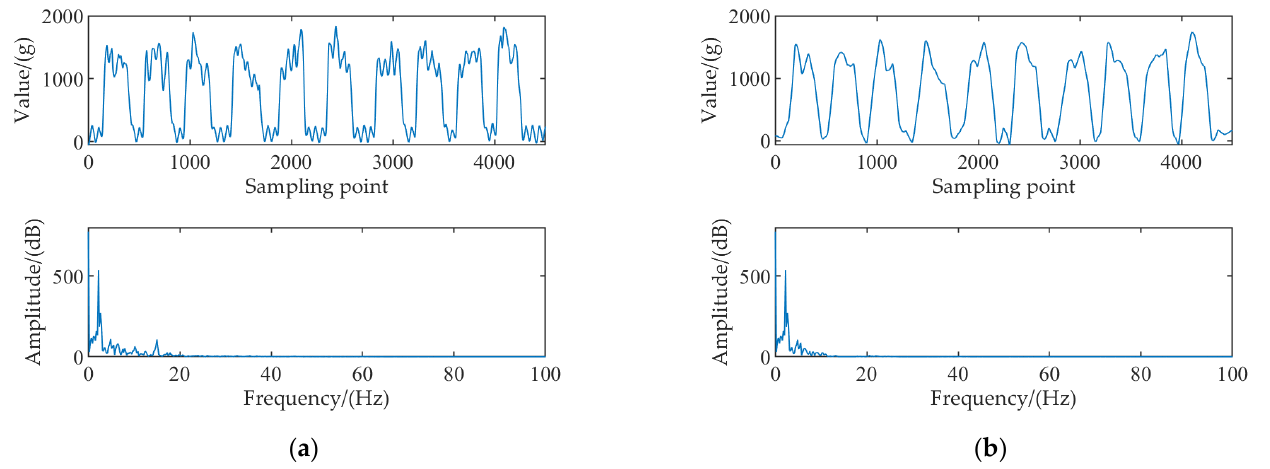
Figure 6. VMD and VMD − WT denoising results of the tea dynamic weighing signal: ( a ) VMD denoising result and spectrum analysis; ( b ) VMD − WT denoising result and spectrum analysis.